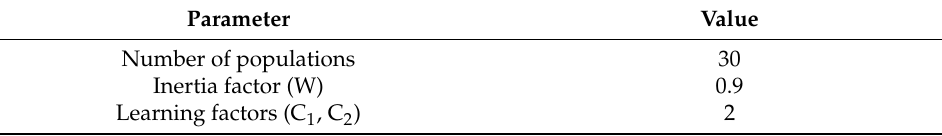
Table 3. PSO parameters used for the